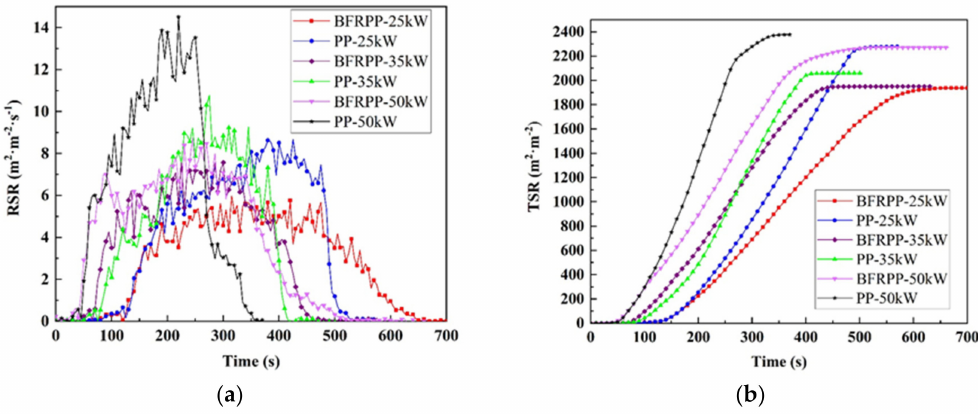
Figure 15. Rate of smoke release (RSR) and total smoke release (TSR) curves: ( a ) RSR and ( b )